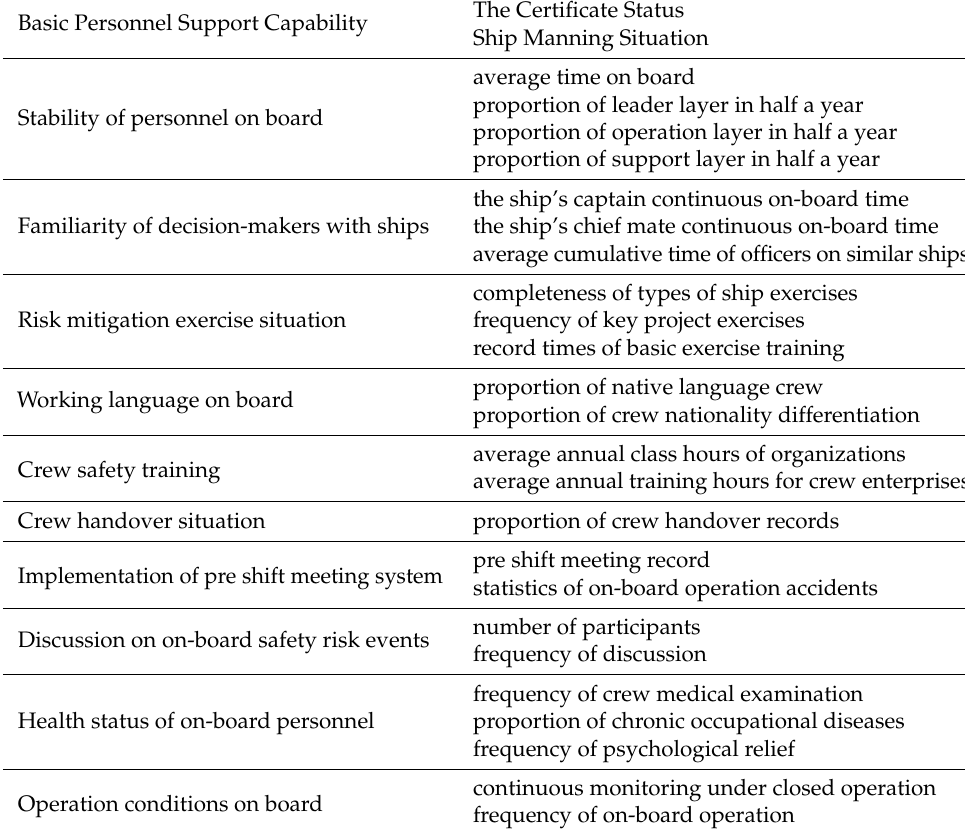
Table 4. Capability indicators of human